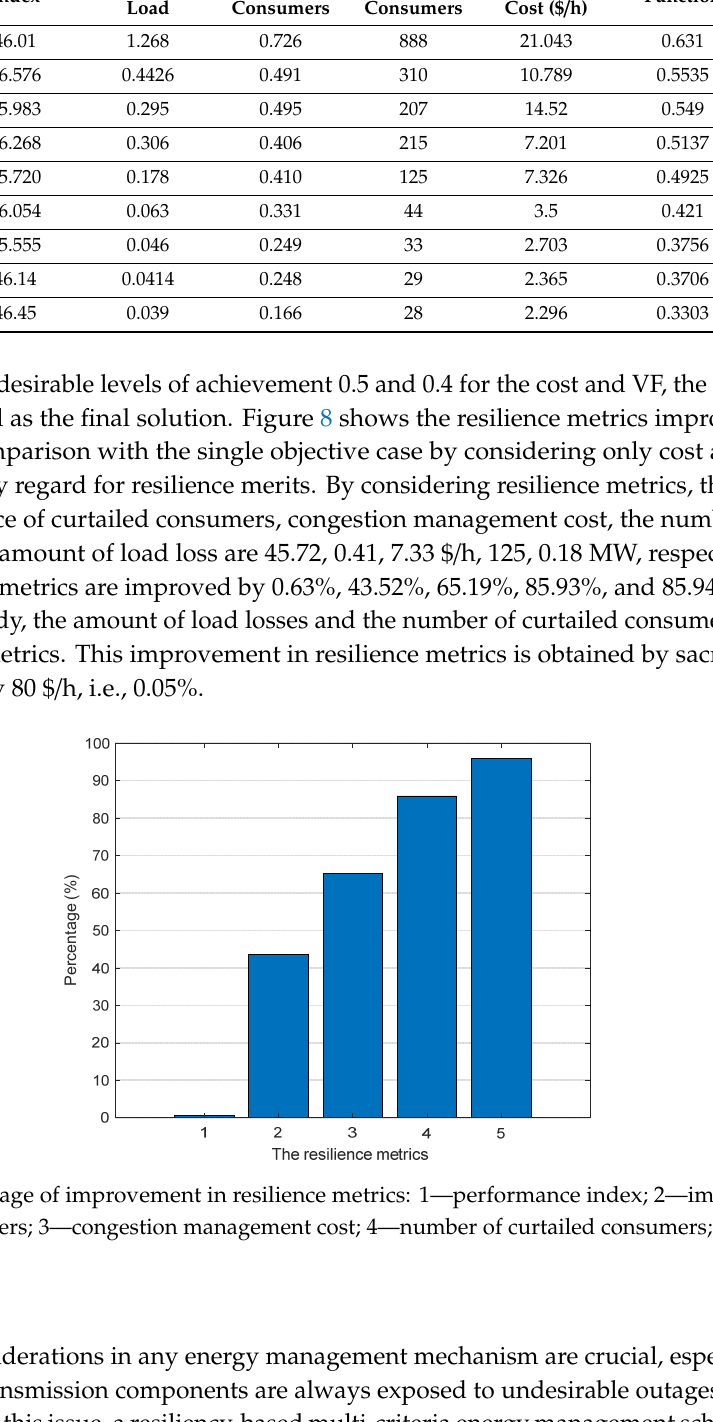
Figure 8. Percentage of improvement in resilience metrics: 1—performance index; 2—importance of